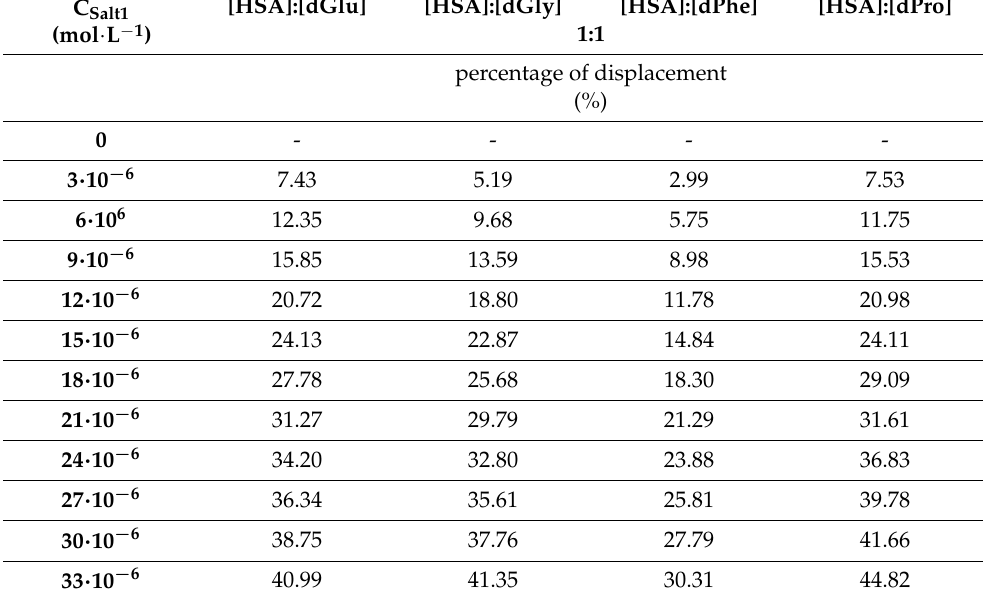
Table 7. The percentage of displacement of dansylated amino acids from the HSA molecule in the presence of Salt1 concentration; [HSA] = [dGlu] = [dGly] = [dPhe] = [dPro] = 5 · 10 − 6 mol · L − 1 ; λ ex 350